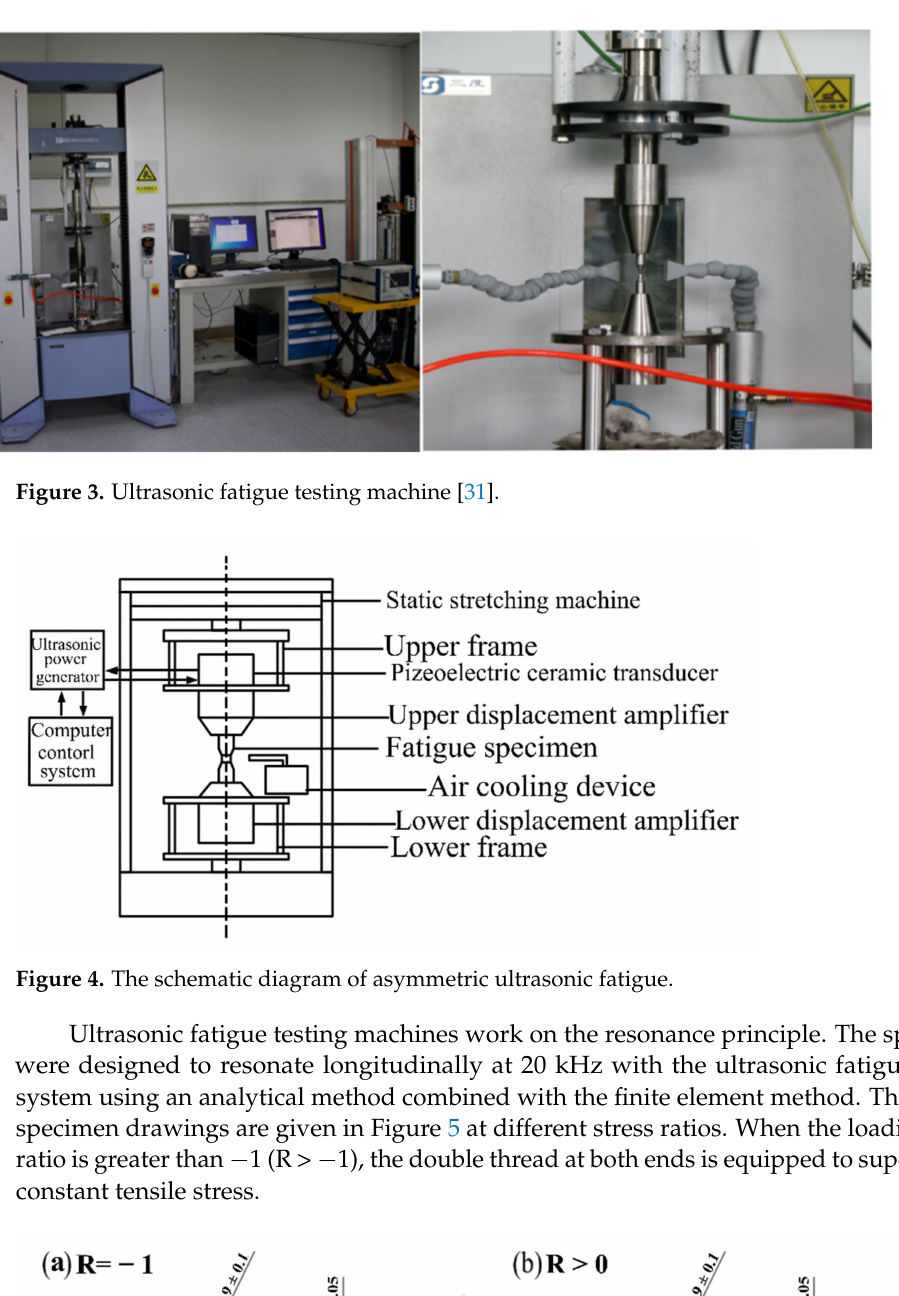
constant tensile stress.